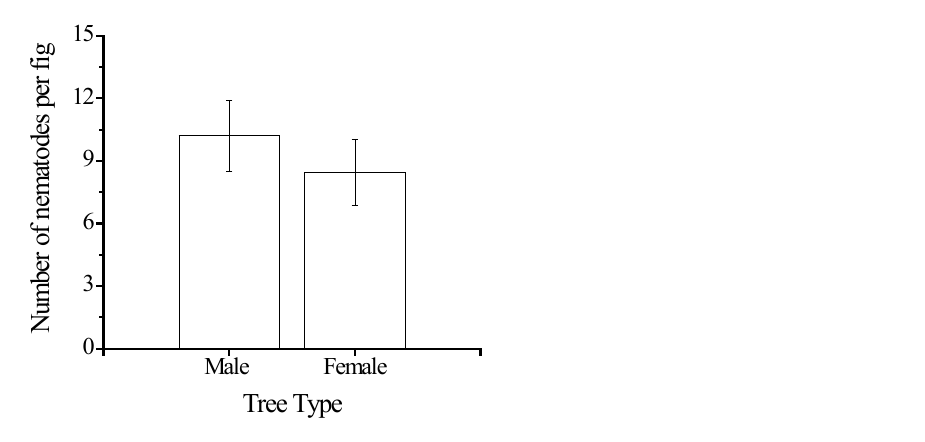
Figure 2. The number of nematodes present inside B phase figs from male and female trees of Ficus hispida , soon after the fig wasp vectors of nematodes entered and died (means ± SE, N = 15 figs from male trees, N = 18 figs from female trees).